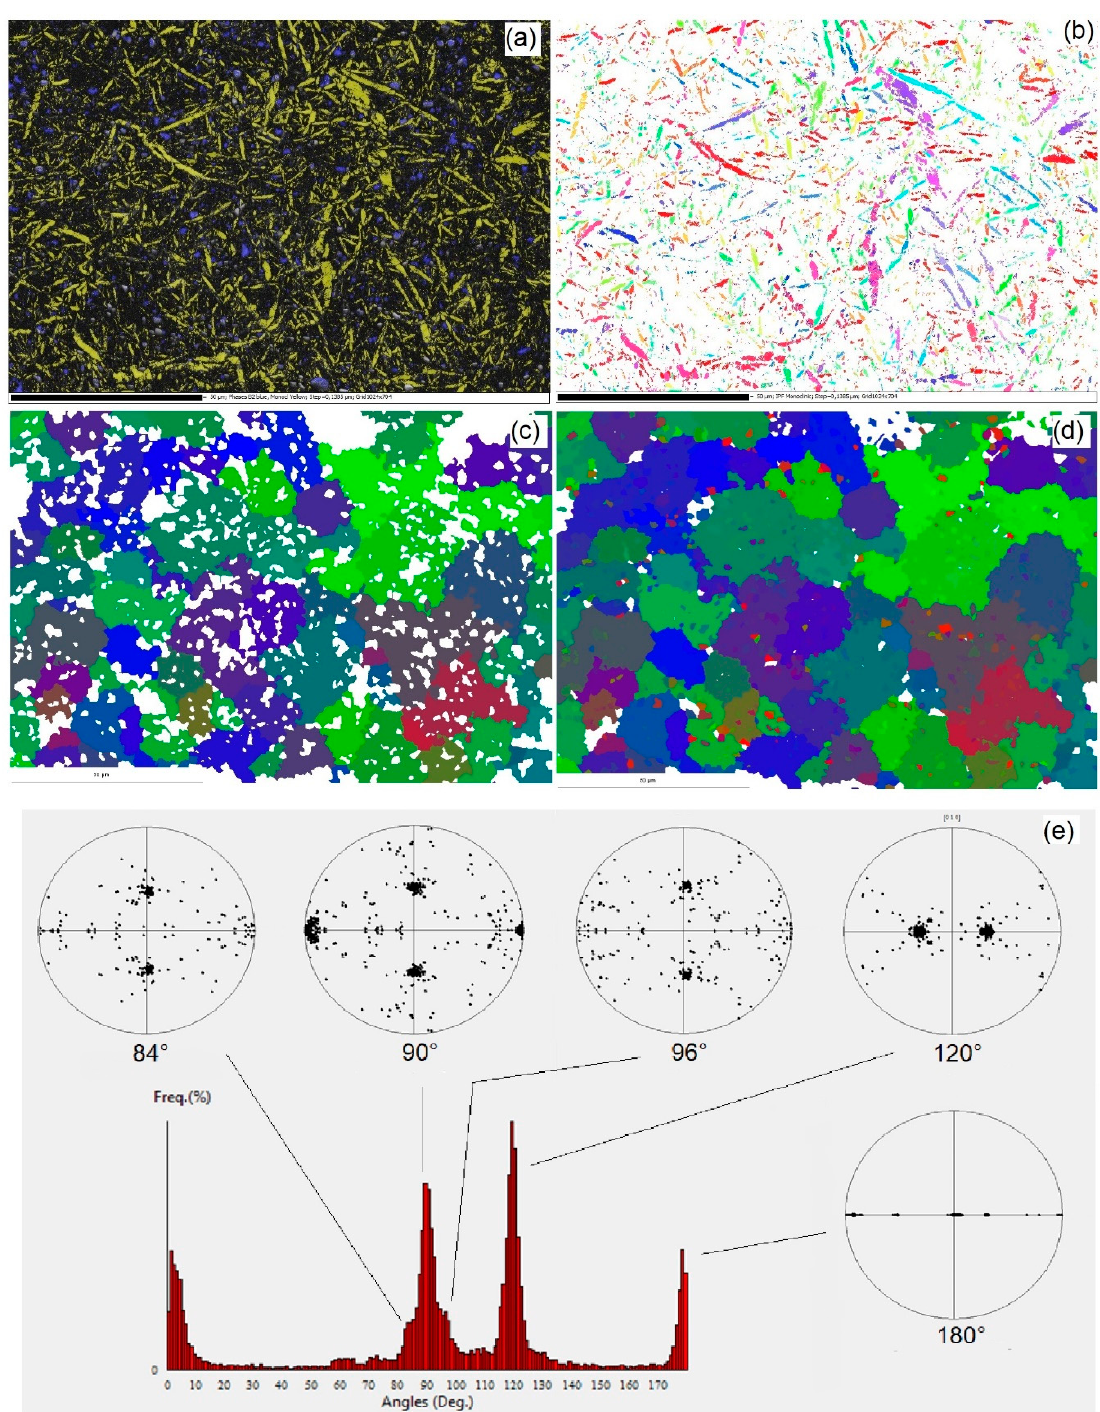
Figure 4. Electron BackScatter Diffraction (EBSD) map 1. ( a ) Phase map with the B19 ′ martensite in yellow and the “reversed” B2 phase in blue, ( b ) orientations of the B19 ′ martensite in x-axis Inverse Pole Figure (IPFx) colors, ( c ) B2 parent grains reconstructed by ARPGE from the B19 ′ martensite, ( d ) same map overlapped with the cubic phase (precipitates or “reversed” B2 grains) in IPFz colors, ( e ) histogram of disorientations between the B19 ′ martensite present in the reconstructed parent B2 grains. The rotation axes are plotted in a pole figure according to the convention explained in Figure 6. The scale bar is 50 μ m.